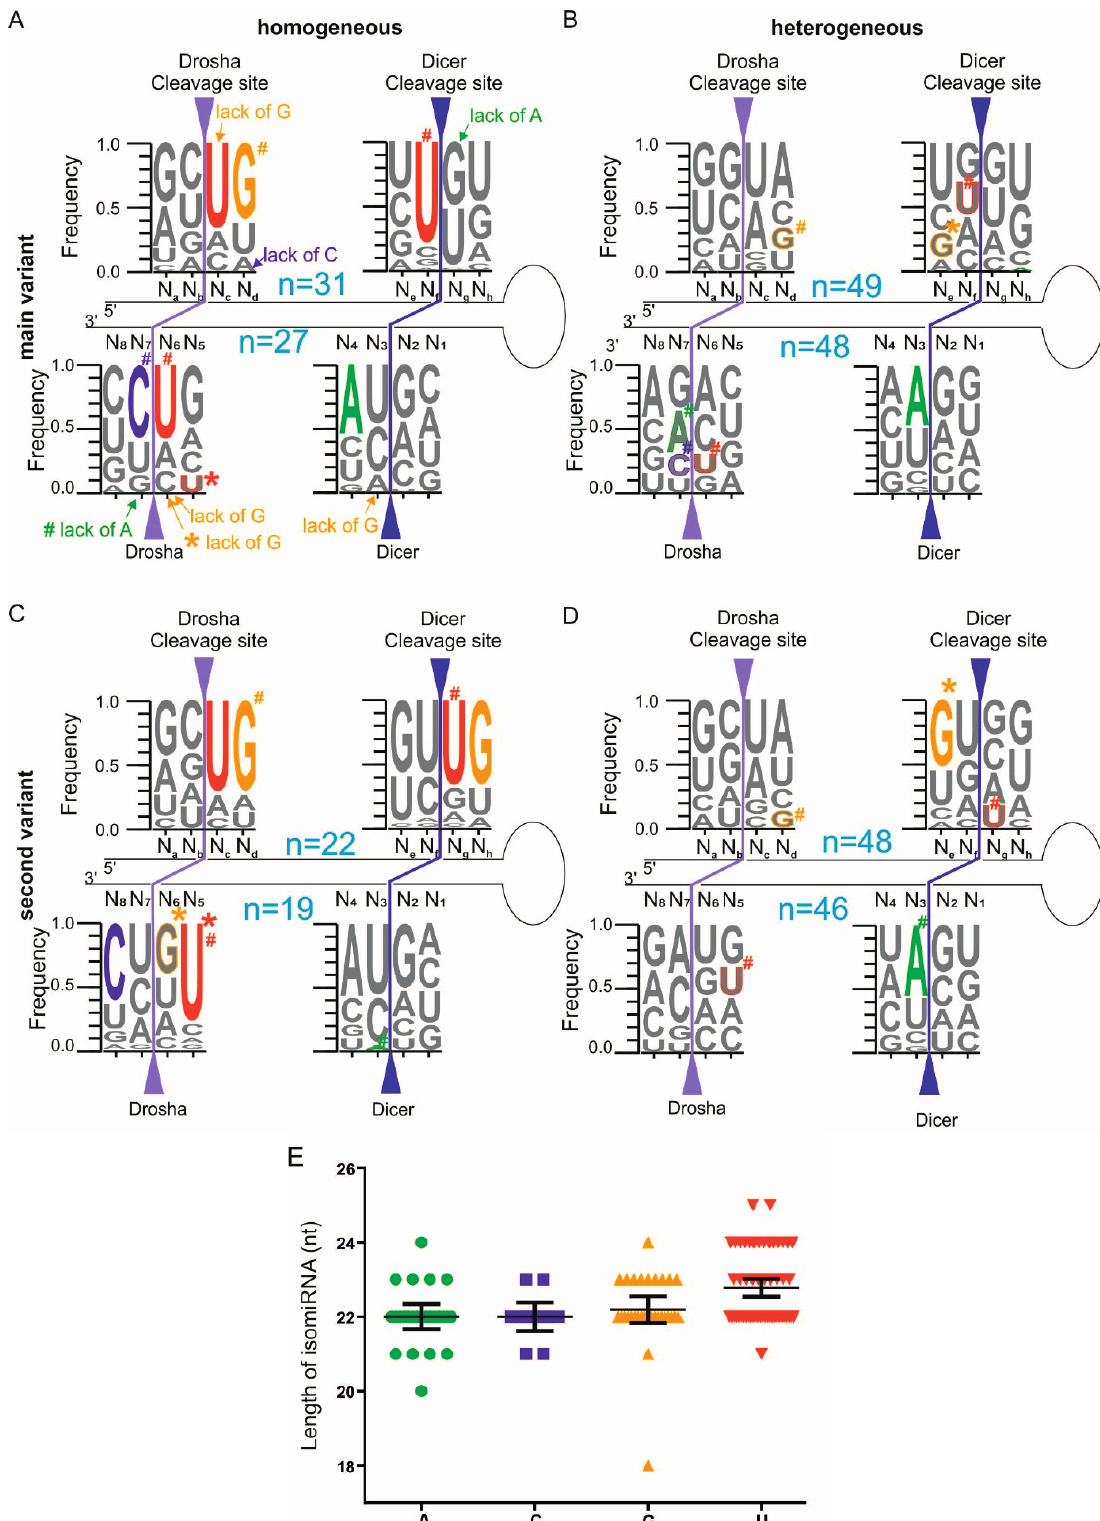
Figure 2. The nucleotide frequencies at hairpin positions surrounding the main ( A , B ) and the second-most-frequent ( C , D ) miRNA variants among the homogenous ( A , C ) and heterogeneous miRNAs ( B , D ) are presented as WebLogo sequences. The nucleotides that are significantly different from the background (Figure 1B) are marked with solid-color letters or appropriate designations ( p < 0.00078, two-sided Fisher’s exact test with